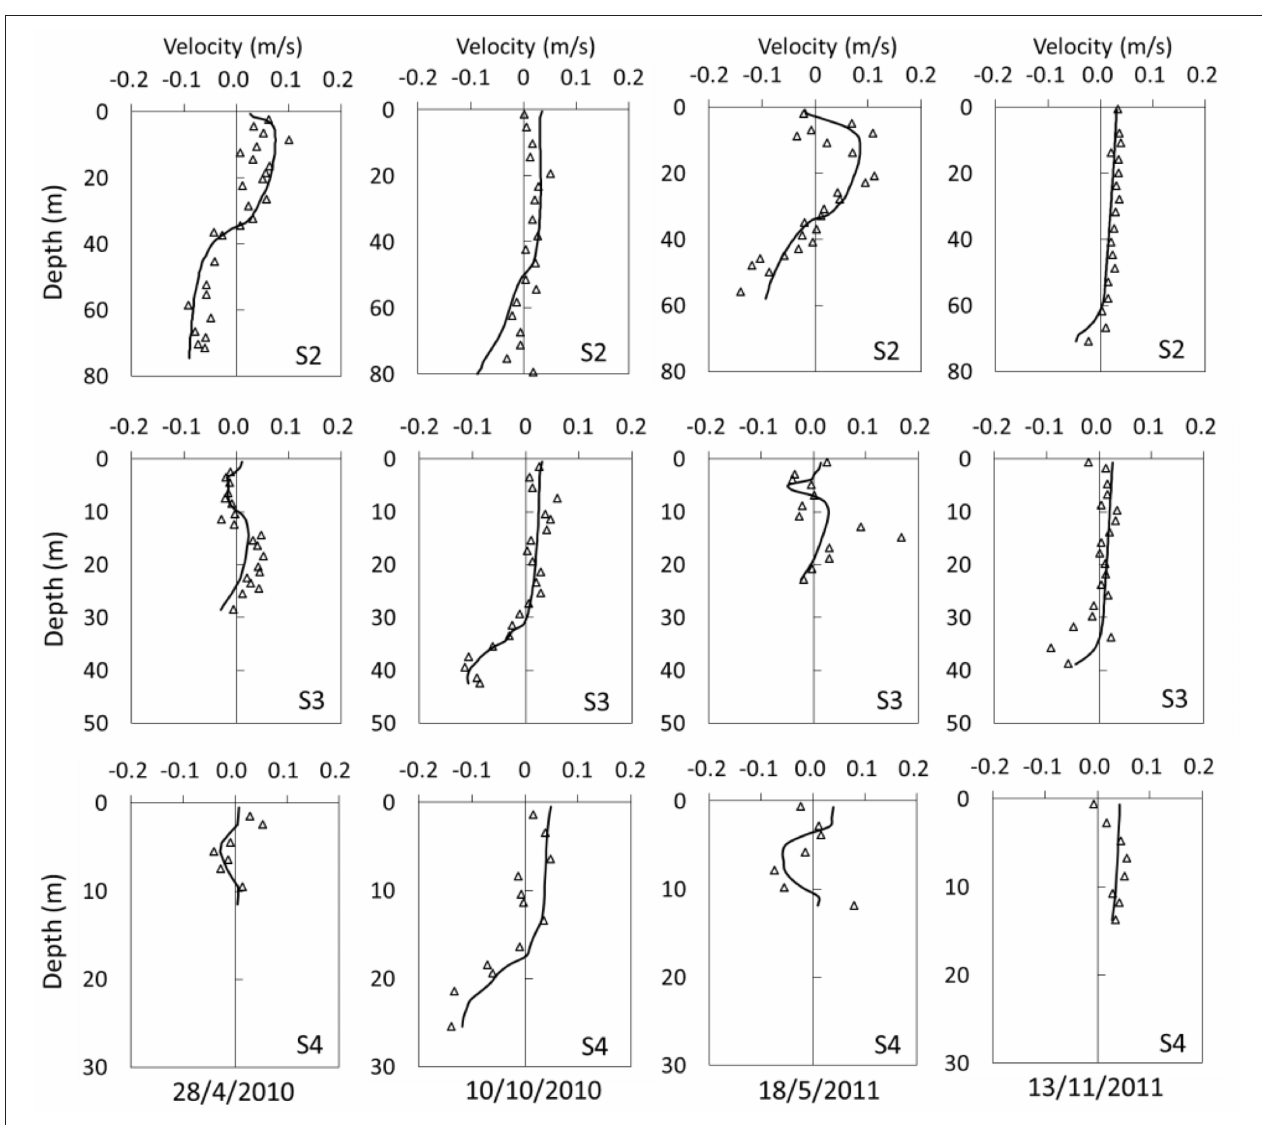
FIGURE 2 | Observed and modeled vertical profiles of velocity at sites S2, S3, and S4.